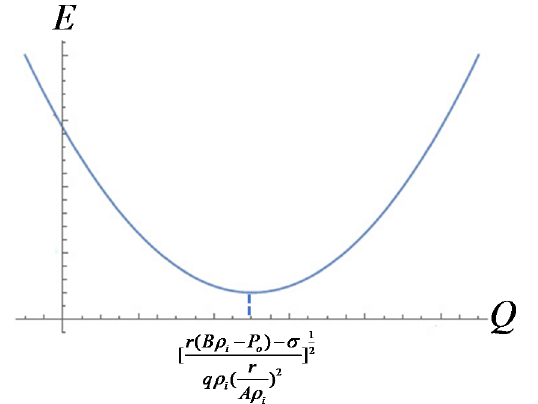
Polymers 2020 , 12 , x FOR PEER REVIEW Figure 4, the electric field became the weakest.